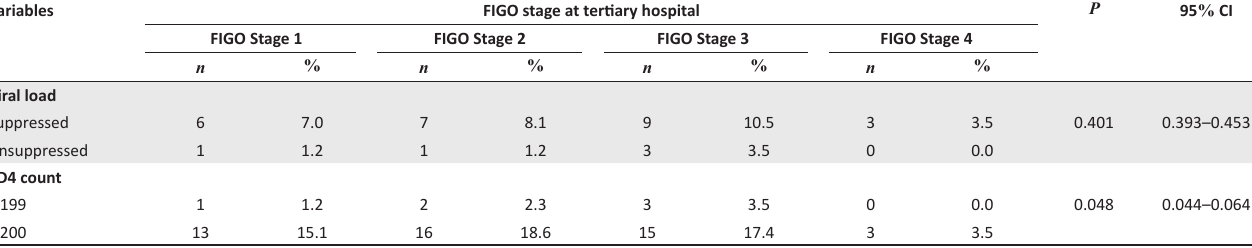
FIGO, International Federation of Gynaecology and Obstetrics; CI, confidence interval. TABLE 5: International Federation of Gynaecology and Obstetrics surgical stage and primary treatment at tertiary hospital. Variables N %